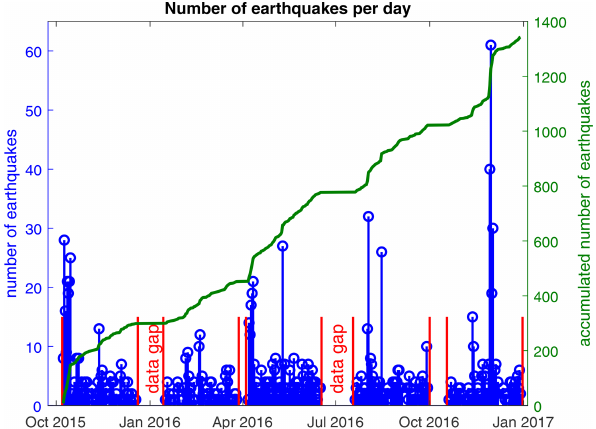
Figure 3. Blue: number of detected earthquakes per day from Octo- ber 2015 to December 2016. Green: accumulated number of earth- quakes. Red lines indicate periods with data